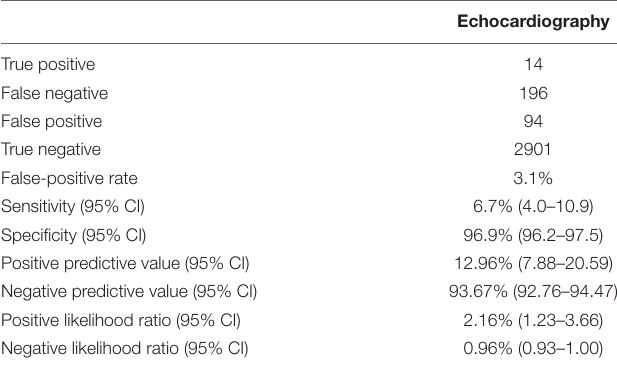
TABLE 3 | Accuracy of echocardiography for detection of cardiac cheat pain in children with chest